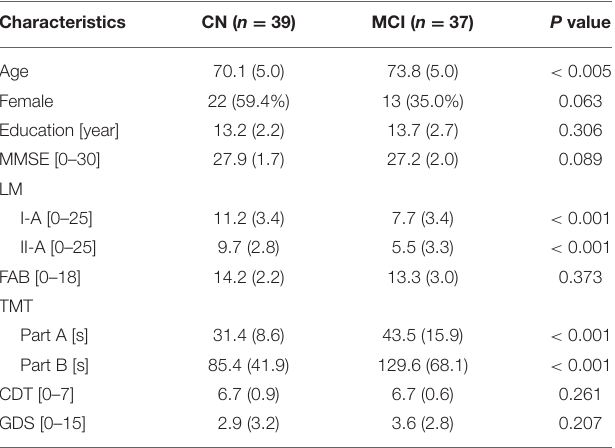
TABLE 1 | Demographics and clinical information of cognitively normal (CN) participants and those with mild cognitive impairment (MCI).